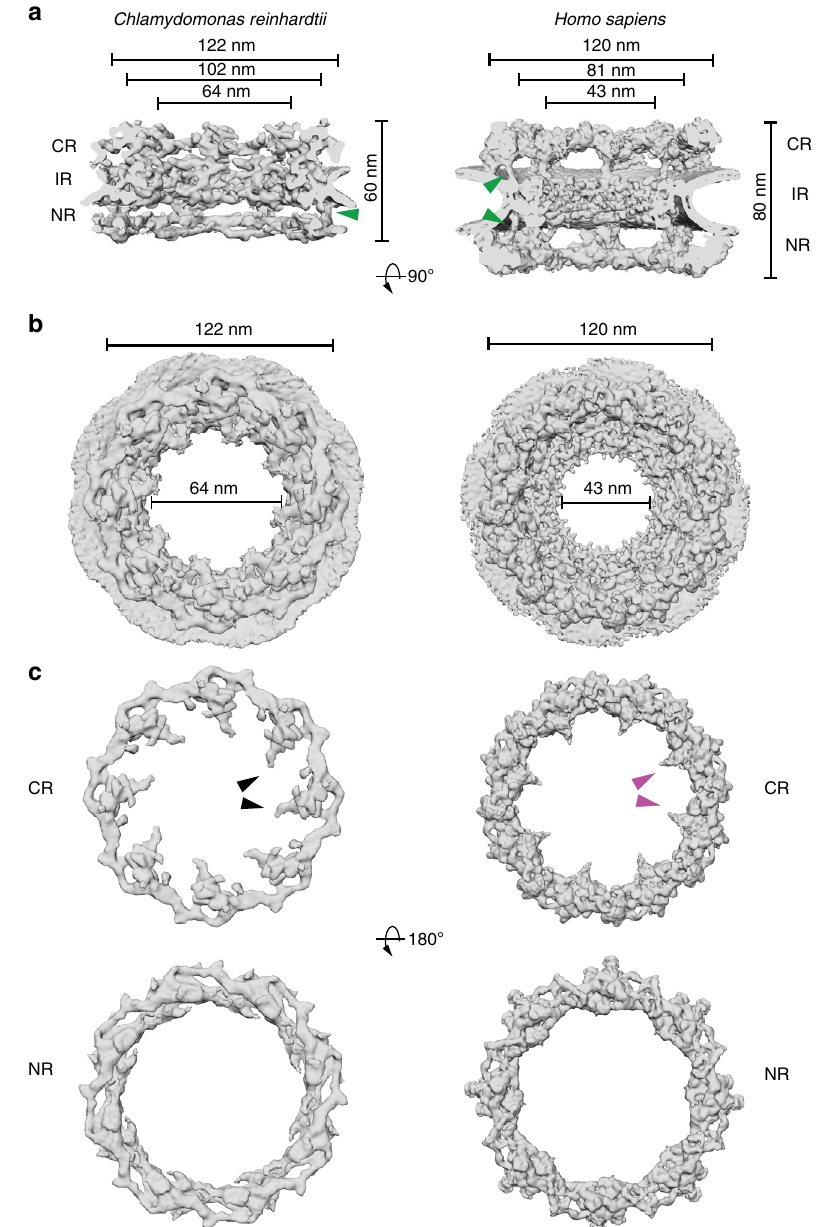
Fig. 1 Structure of the Cr NPC in comparison to the Hs NPC. a Structures are displayed as rendered isosurfaces, sliced through the central axis. Green arrowheads indicate the connector element, which is absent from the cytoplasmic side of the Cr NPC. b Cytoplasmic face view. The Cr NPC central channel is dilated. c Cytoplasmic and nuclear rings of both NPCs. The Cr NPC cytoplasmic ring has reduced density compared to the Hs NPC. Black and magenta arrowheads indicate the density attributed to the Nup159 (Nup214 in humans) subcomplex, which forms cytoplasmic fi laments that protrude towards the central channel. CR cytoplasmic ring, IR inner ring, and NR nuclear